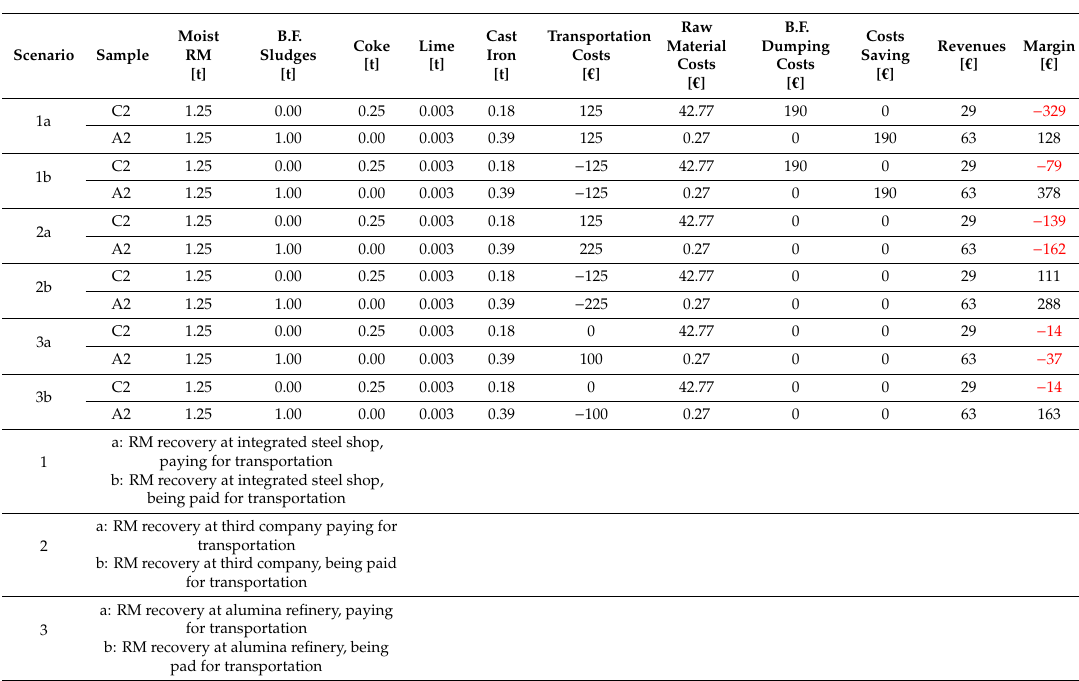
Table 6. Economical evaluation of the proposed process based on the treatment of 1 t of dried red mud. Blast furnace